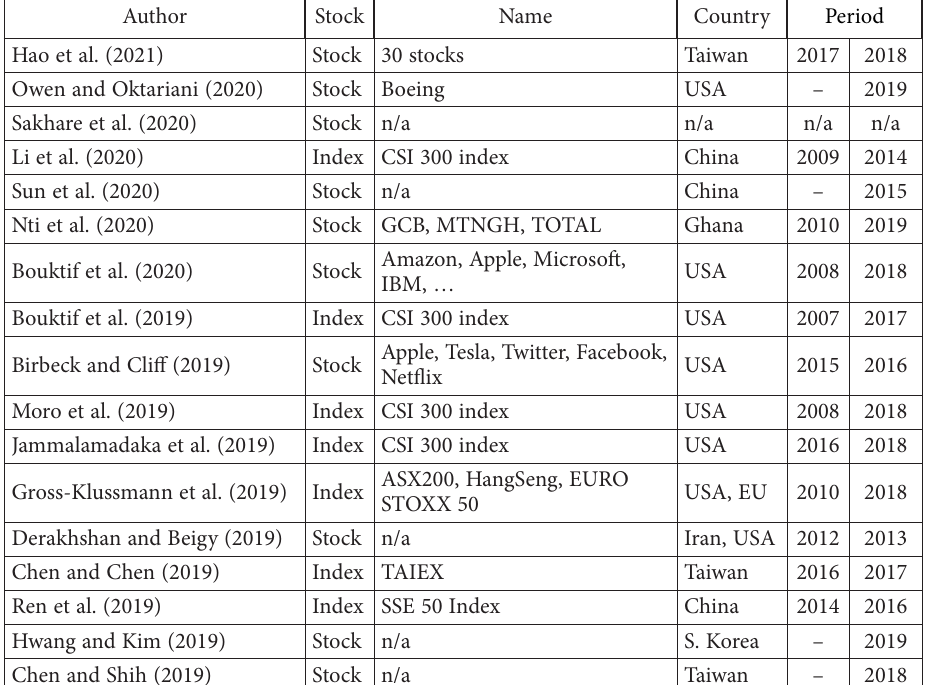
Table 2. Sources of numerical structured data (source: Janková,